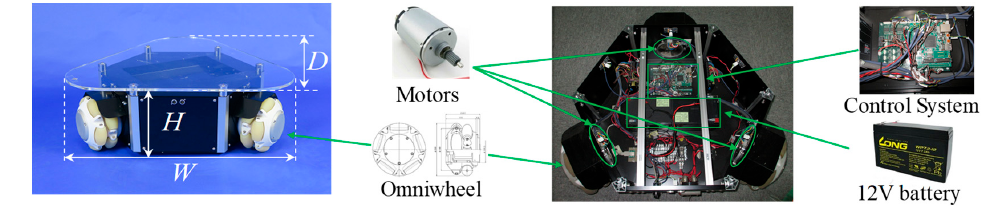
Figure 1. Appearance of the indoor carrier robot.